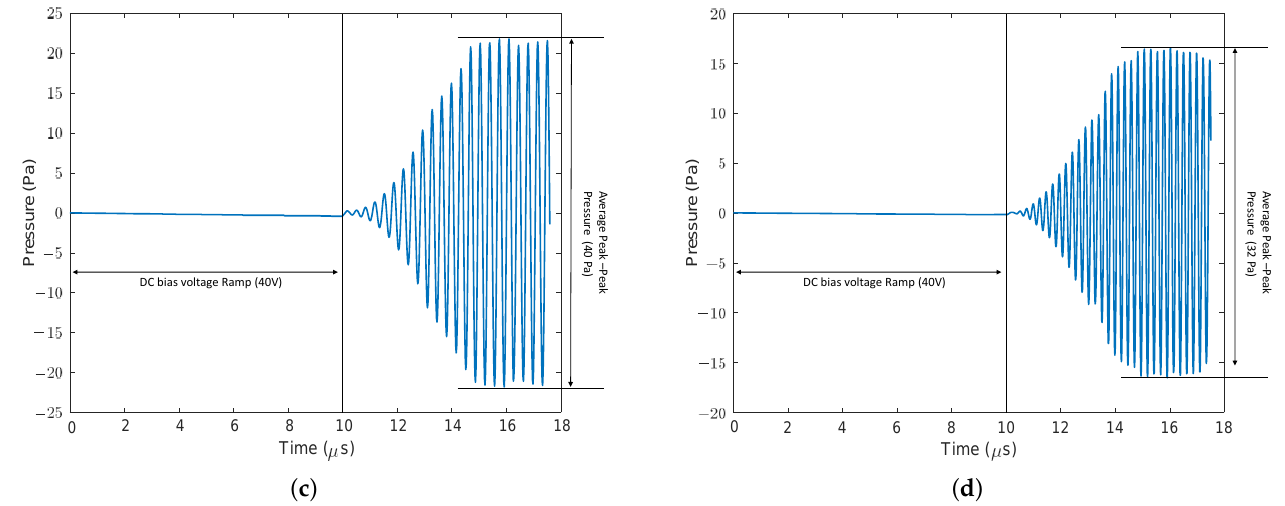
Figure 14. Pressure on CMUTs surfaces. ( a ) Pressure at CMUT-A surface; ( b ) Pressure at CMUT-B surface; ( c ) Pressure at CMUT-C surface; ( d ) Pressure at CMUT-D